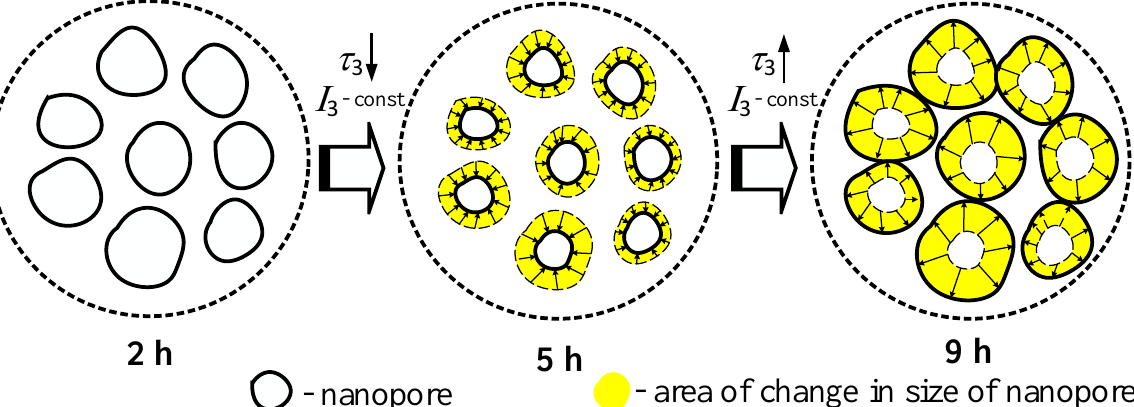
Figure 5. Scheme of nanopores evolution near grain boundaries in MgAl 2 O 4 ceramics sintered at 1300 °C during 2, 5, and 9 h.